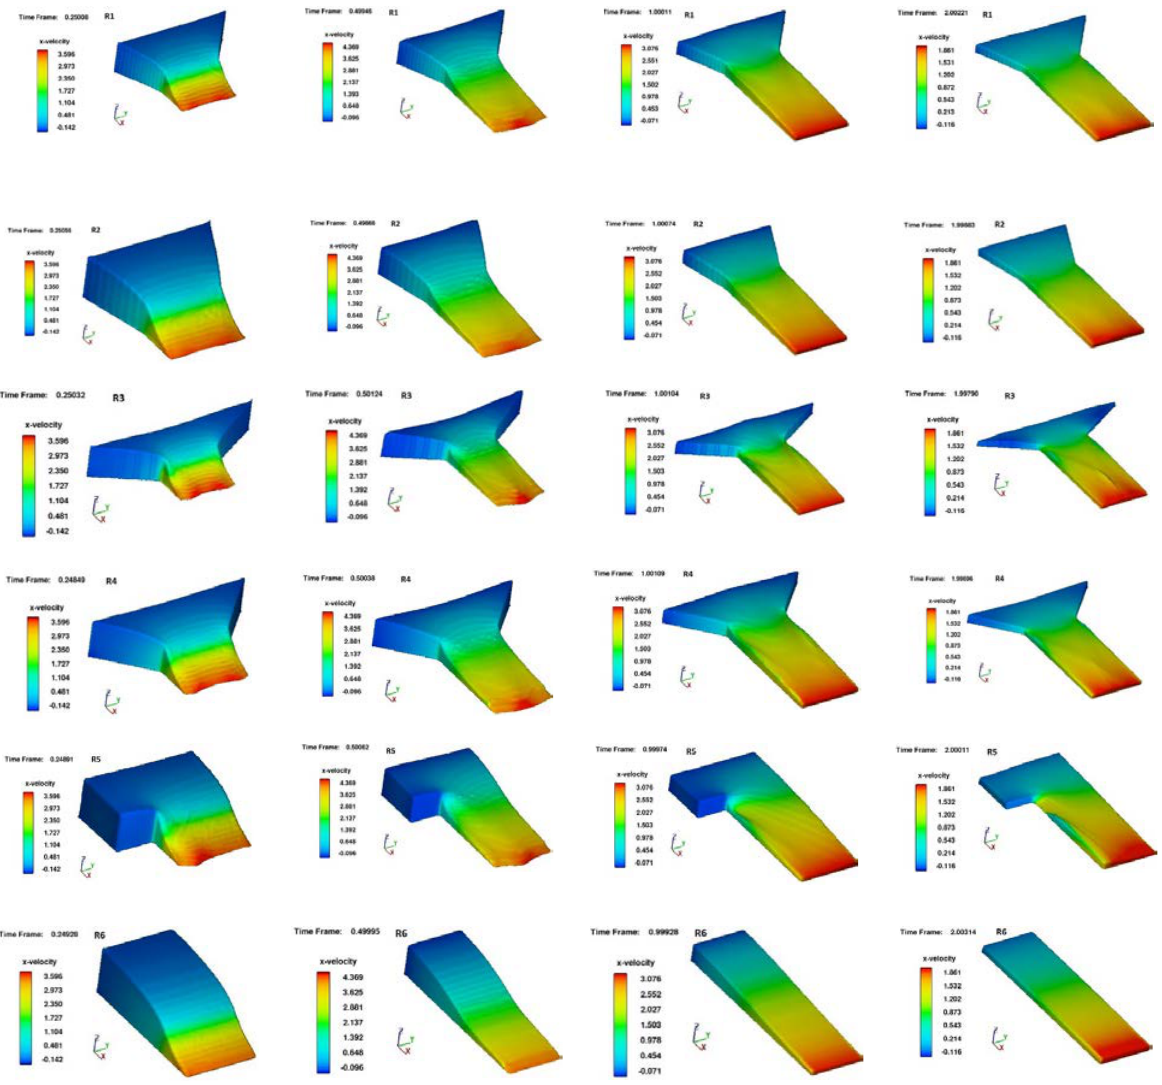
Fig. 12. x -velocity for all reservoirs at t= 0.25, 0.5, 1, and 2